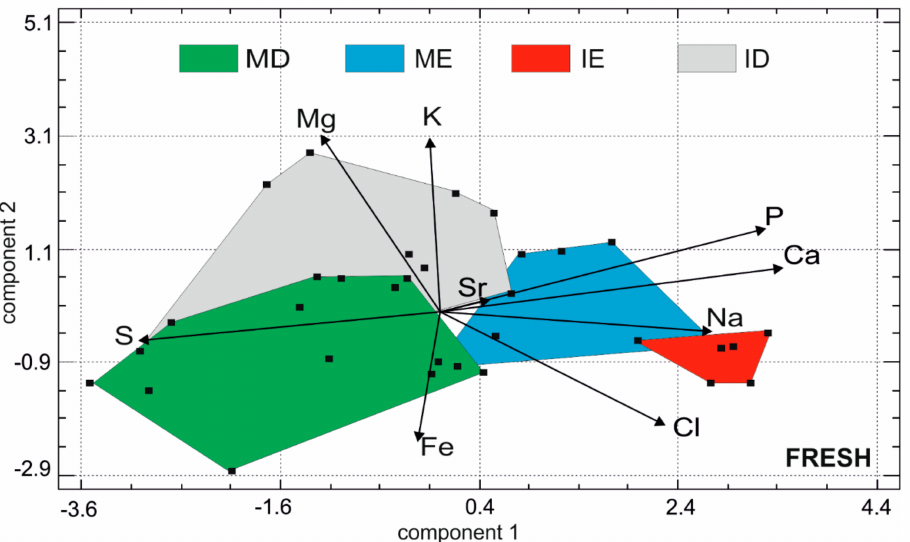
Figure 5. Principal component plot based on the chemical compositions of the fresh teeth. ME: molar enamel, IE: incisor enamel, MD: molar dentine, ID: incisor